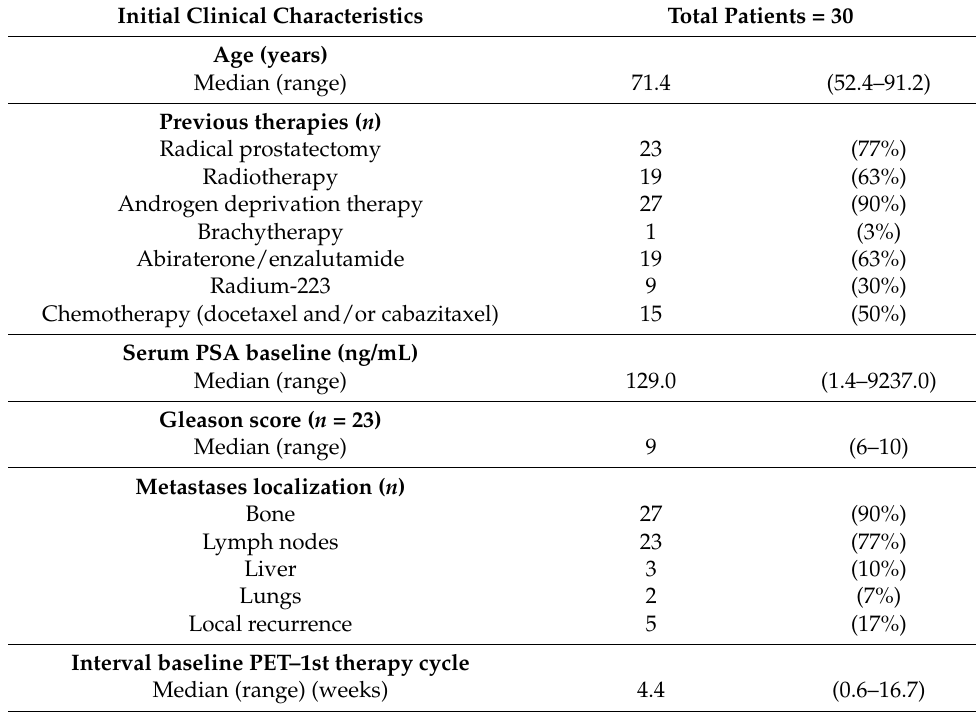
Table 1. Initial clinical characteristics of the included